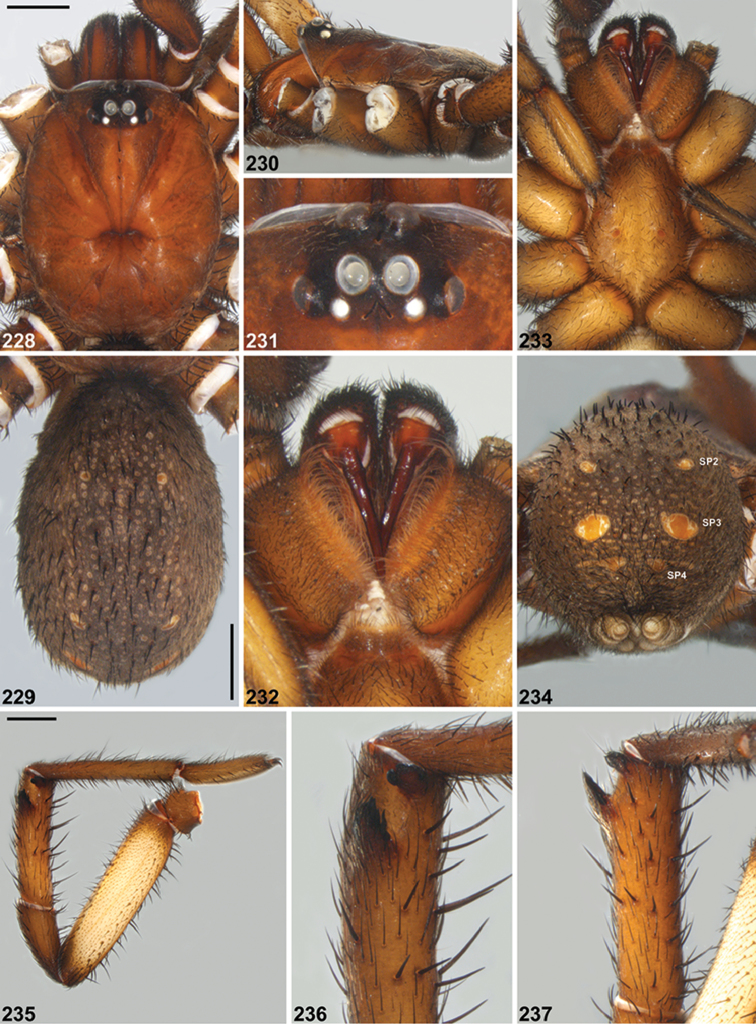

Idiosoma
jarrah sp. n., male holotype (WAM T124143) from Lesmurdie (Western Australia; JAF), somatic morphology. 228–229 Carapace and abdomen, dorsal view 230 Carapace, lateral view 231 Eyes, dorsal view 232 Mouthparts, ventral view 233 Sternum, ventral view 234 Abdomen, posterior view 235 Leg I, prolateral view 236 Leg I tibia, clasping spurs, prolateral view 237 Leg I tibia, proventral view. Scale bars 2.0. SP2–4 = sigilla pairs 2–4.